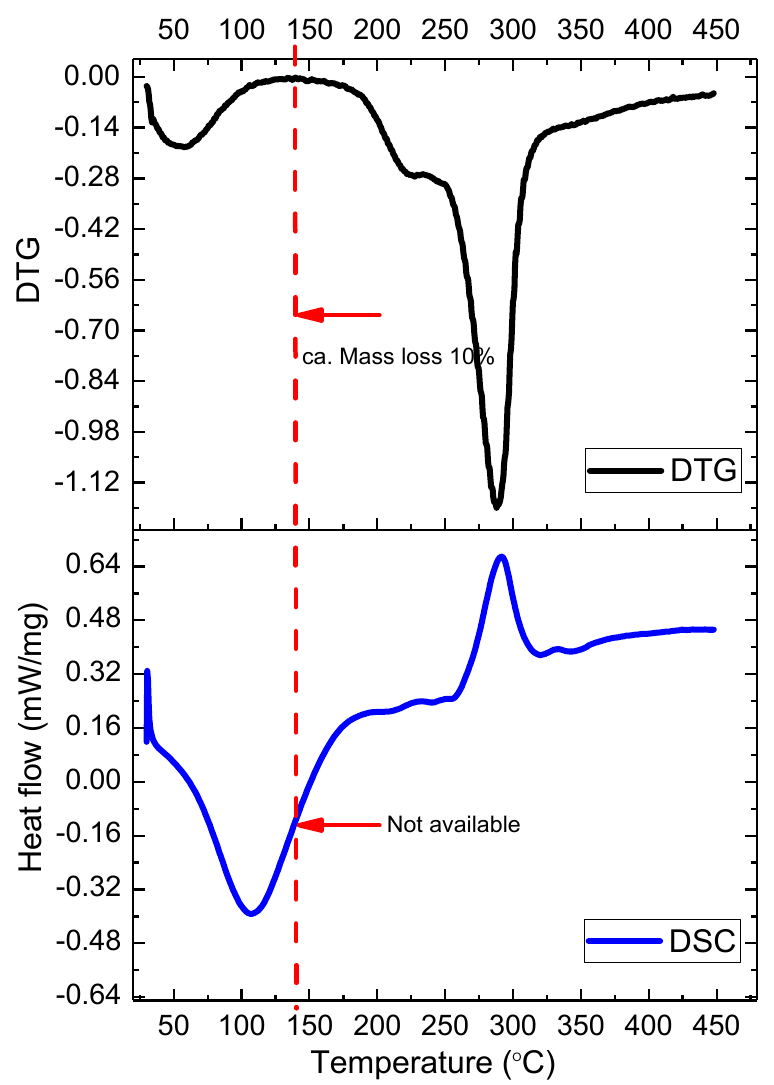
Figure 5. Comparisons of the differential scanning calorimetry (DSC) and differential thermogravimetric (DTG) curves of the T. fuciformis polysaccharides obtained from freeze-drying under a nitrogen condition at the selected heating rate of 6 °C/min.